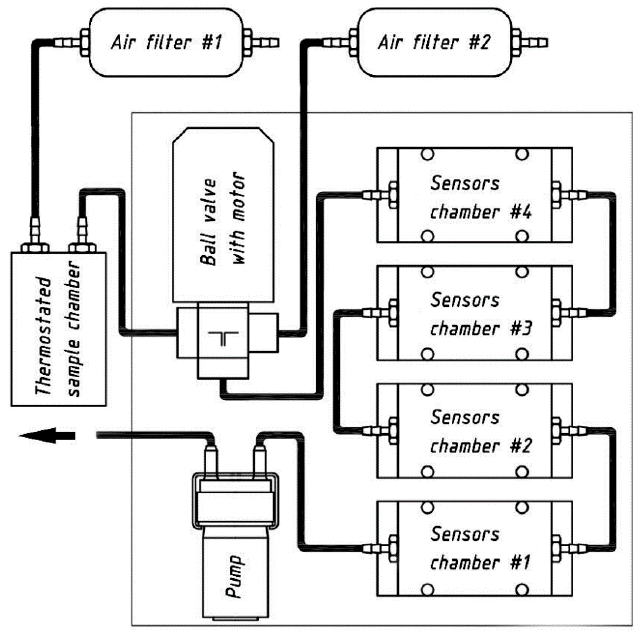
Figure 5. Schematic diagram of the e ‐ nose depicting its different components [144] .